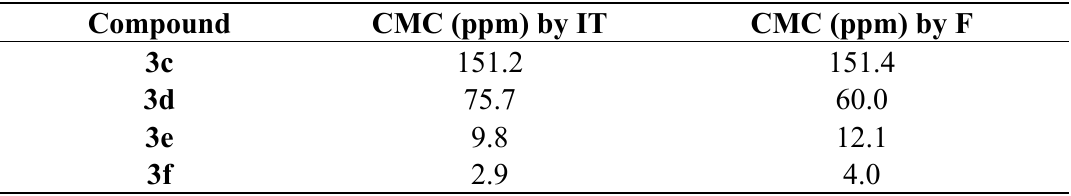
Table 2. CMCs values of 3c–3f determined by interfacial tensiometry (IT) and by Steady-state fluorescence (F)